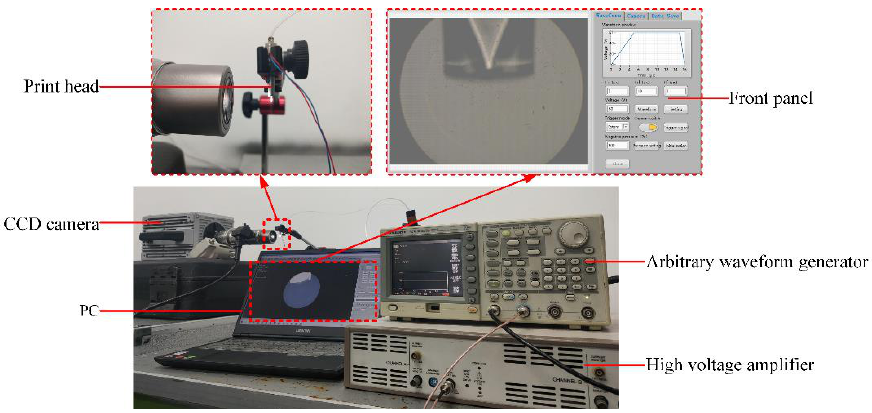
Figure 16. Experimental setup.